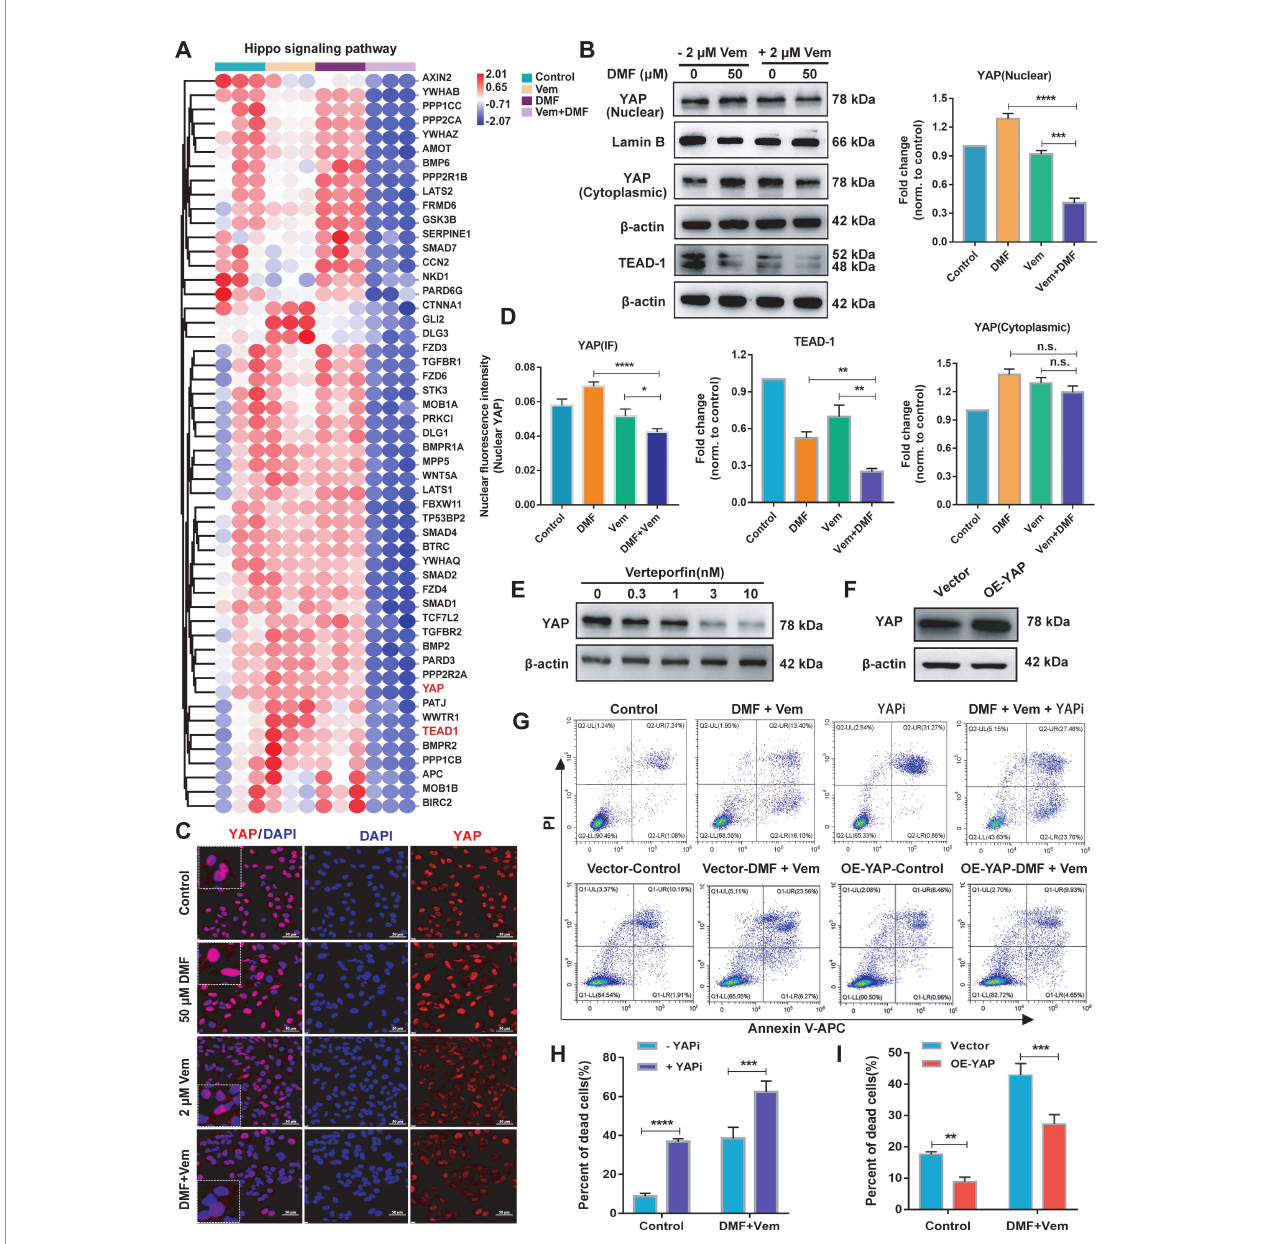
FIGURE 5 | Effects of DMF/Vem treatment on Hippo pathway in melanoma cells. (A) The heat maps of Hippo pathway related genes downregulated upon DMF/ Vem treatment. (B) Western blot analysis of nuclear and cytoplasmic YAP as well as TEAD-1 levels, with Lamin B or b -actin as loading control. Protein expression in western blot was determined by densitometry (gray value) calculations with Image J software. Data were expressed as mean ± SD (n=3), ** P < 0.01, *** P < 0.001, **** P < 0.0001 vs. DMF or Vem treatment, n.s., not signi fi cant, using one-way ANOVA. (C) Representative YAP IF-staining images of A375 cells, scale bar=50 m m. (D) The fl uorescence intensity of (C) was measured by Image-Pro-Plus 6.0 (Media Cybemetics, USA). * P < 0.05, *** P < 0.001, n.s., not signi fi cant, using one-way ANOVA. (E) Western blot analysis of YAP levels. For this assay, A375 cells were treated with different doses of YAPi (vertepor fi n) for 24 h. (F) Western blot analysis of YAP overexpression levels. A375 cells were transfected with YAP overexpression vector for 72 h. (G) Representative fl ow cytometry pro fi les of A375 cells stained with Annexin V and PI. Top : Flow cytometry was used to assess cell death of A375 treated with DMF/Vem or 3 nM vertepor fi n plus DMF/Vem for 24 h. Bottom : A375 cells were transfected with YAP overexpression vector for 48 h, then fl ow cytometry was used to assess the cell death after treatment with 50 m M of DMF plus 2 m M of Vem for 24 h. (H) Quantitative and statistical analysis of the data from (F: Top ). Data were shown as mean ± SD (n=3), *** P < 0.001, **** P < 0.0001, using two-way ANOVA to compare the differences between the groups. (I) Quantitative and statistical analysis of the data from (F: Bottom ). Data were shown as mean ± SD (n=3), ** P < 0.01, using two-way ANOVA to compare the differences between the groups.